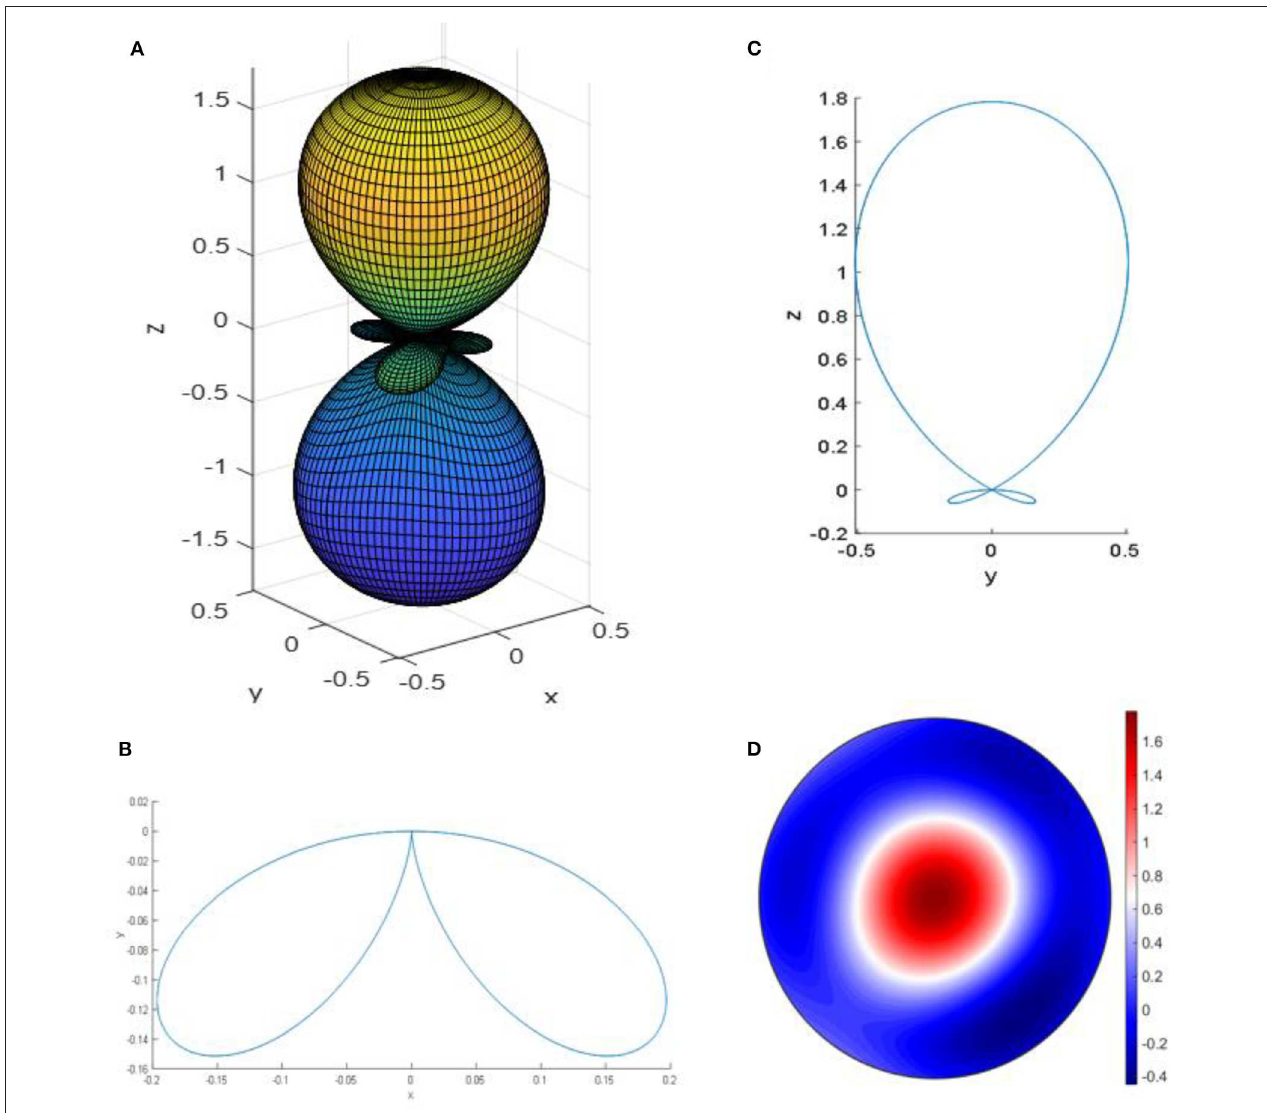
FIGURE 9 | (A) 3D plot, (B) xy 2D plot, (C) yz 2D plot, and (D) the magnitude of the largest value of the elastic modulus of aluminum